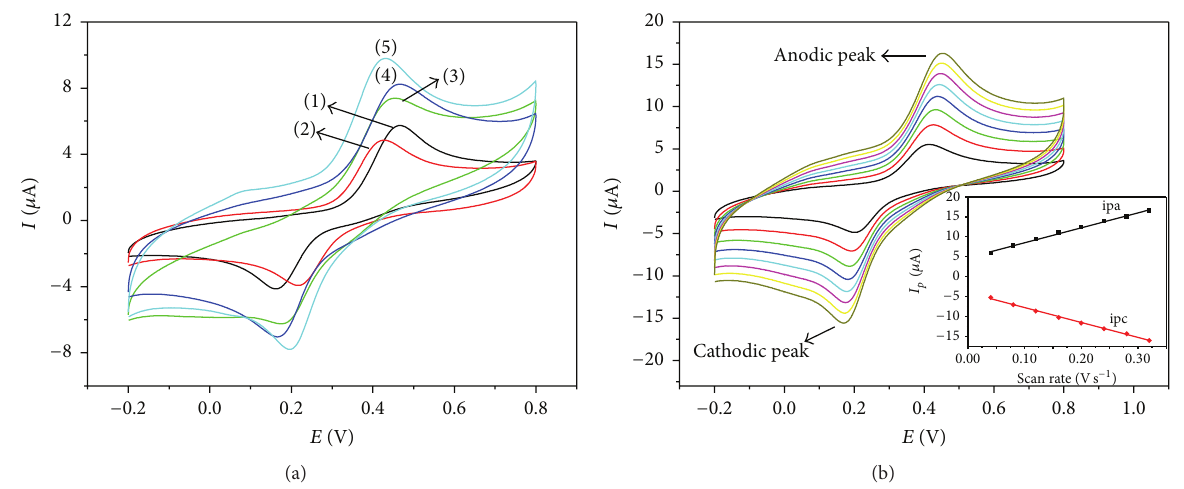
Figure 5: (a) Cyclic voltammograms of (1) bare GCE, (2) PDA/GCE, (3) PDA-Lac/GCE, (4) PDA-Lac-rGO/GCE, and (5) PDA-Lac-rGO- Pd/GCE in 0.1 M acetate buffer solution (pH 5.0) containing 220 𝜇 M catechol at 100mVs −1 . (b) Cyclic voltammograms of PDA-Lac-rGO- Pd/GCE in 0.1M acetate buffer solution (pH 5.0) containing 220 𝜇 M catechol at scan rates of 40, 80, 120, 160, 200, 240, 280, and 320 mVs −1 (from inner to outer), respectively. Inset: plots of the corresponding anodic and cathodic peak currents versus scan rate.